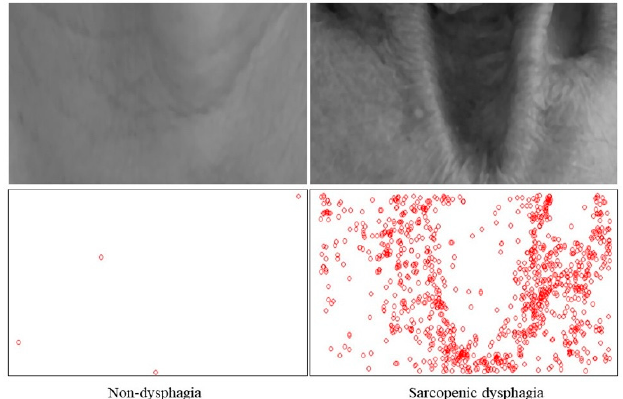
Figure 2. Kernel density curve for image features. Blue = non-dysphagic group, Red = sarcopenic dysphagic group.